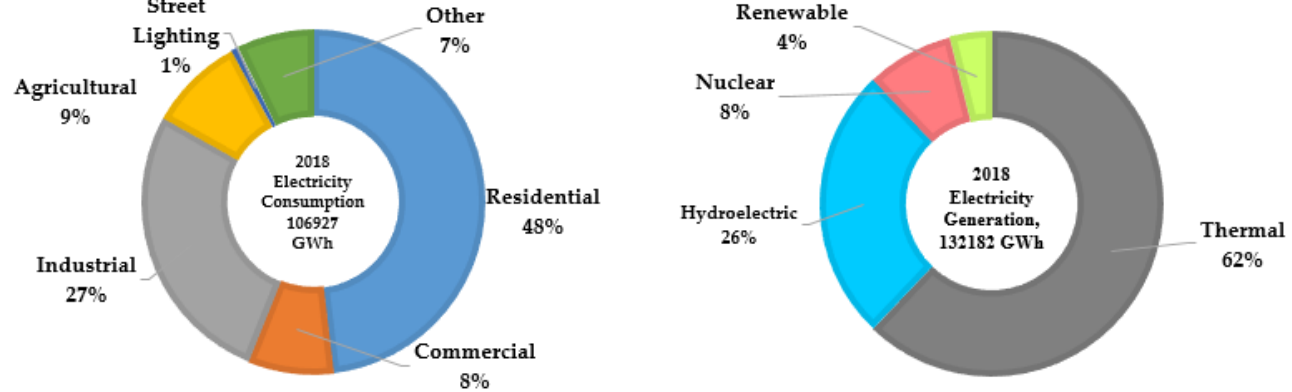
Figure 1. Electricity generation and consumption (share of different sources and sectors) [7].